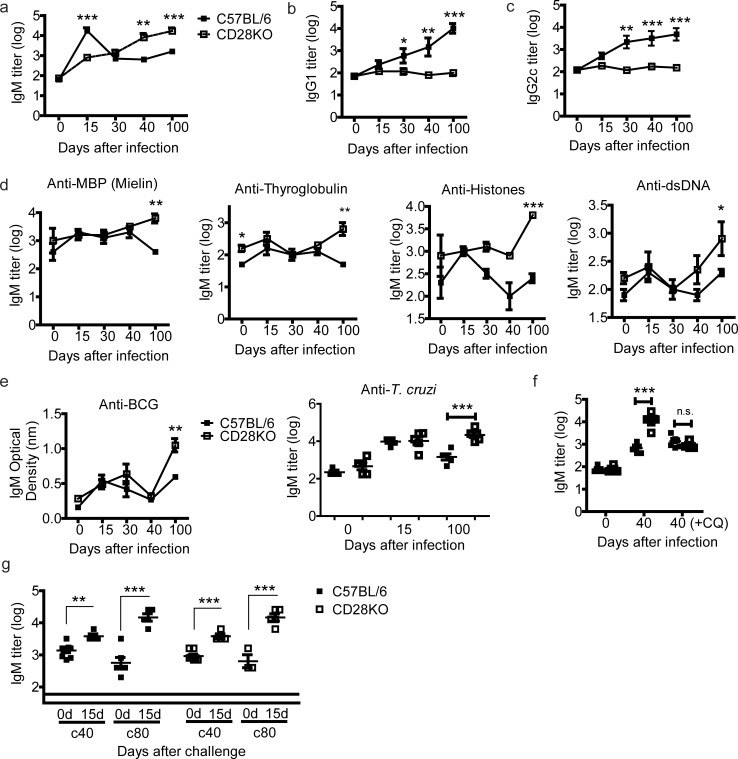
IgM production in C57BL/6 and CD28KO mice during primary and secondary Pc infections.(a-c) Anti-parasite IgM, IgG1 and IgG2c serum titers during primary infection. (d-e) Serum titers of IgM that binds to thyroglobulin (TGB), dsDNA, histone (HST), myelin (MYL), T. cruzi and BCG at 15 and 100 days after primary infection. (f) Anti-parasite IgM serum titers at day 40 p.i. in mice that were or were not treated with chloroquine (CQ). (g) Anti-parasite IgM serum titers in c40 and c80 mice. In a-g, significant differences (*p<0.05, **p<0.01, ***p<0.001) between the indicated groups are shown. Data from three independent experiments (n = 5–7, mean ± SEM) is shown.